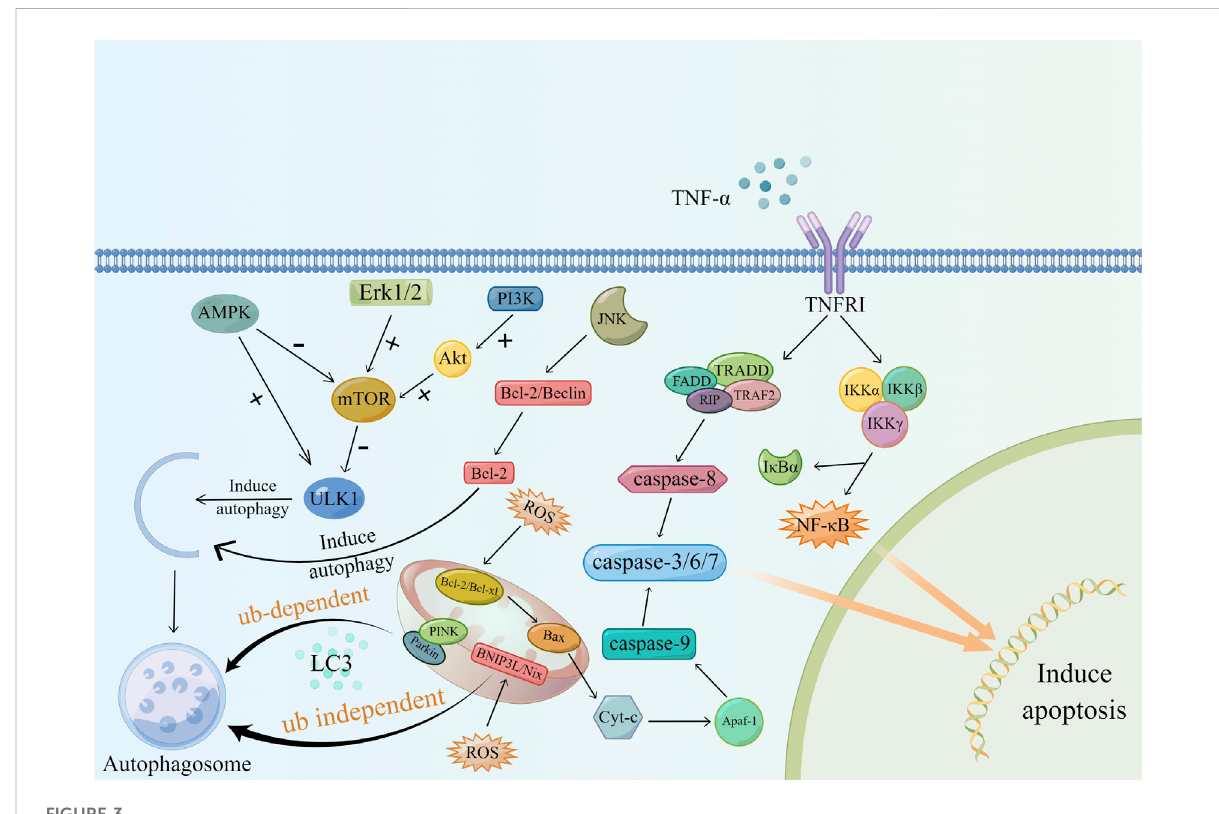
FIGURE 3 Apoptosis regulation and